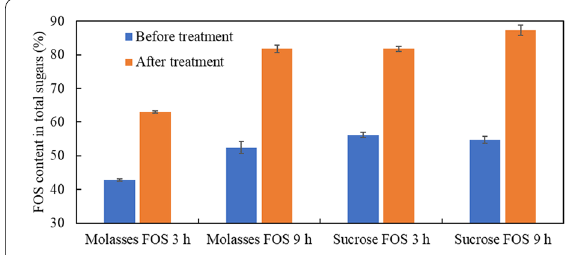
Fig. 5 FOS content improvement after treatment by an invertase-deficient yeast